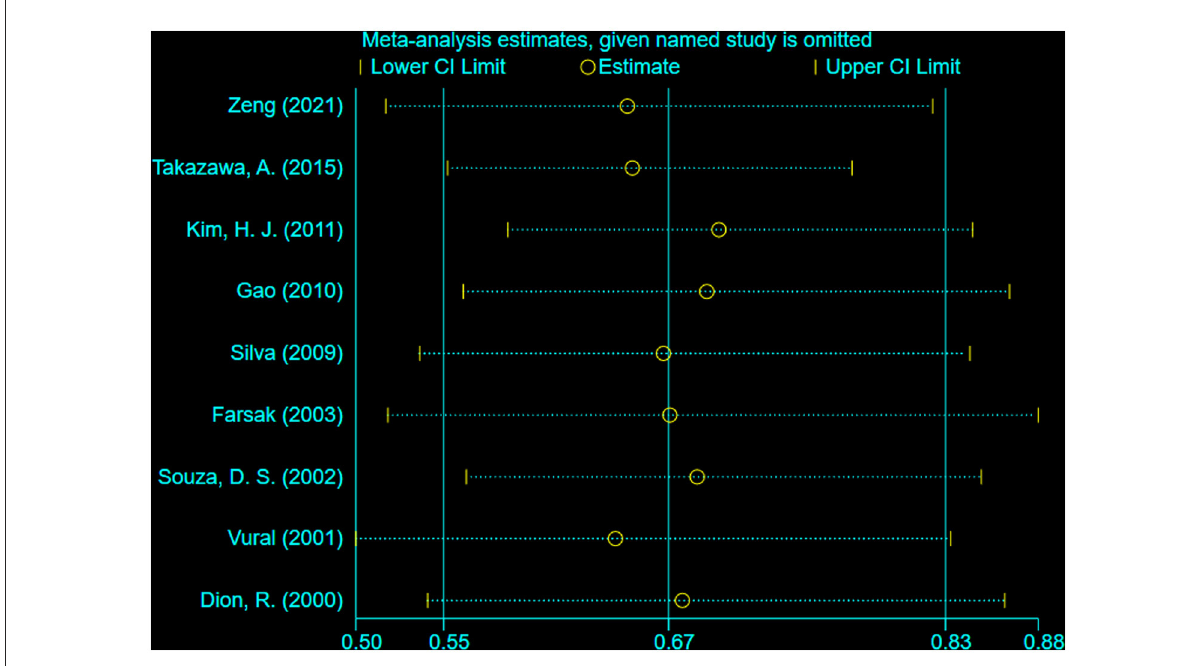
FIGURE4 Sensitivity analysis for graft failure (Leave-one-out analysis). By sequentially eliminating each study from nine studies reporting graft failure, sensitivity analysis showed that no particular study could largely influence the